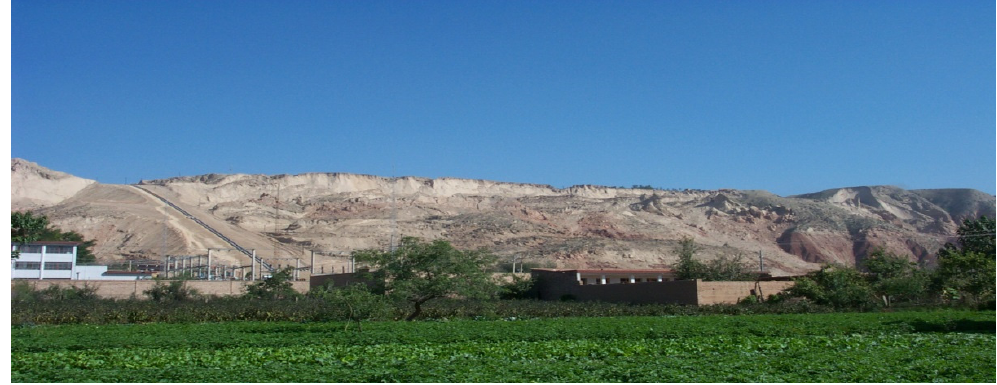
Figure 3. Front edge of Heitai.